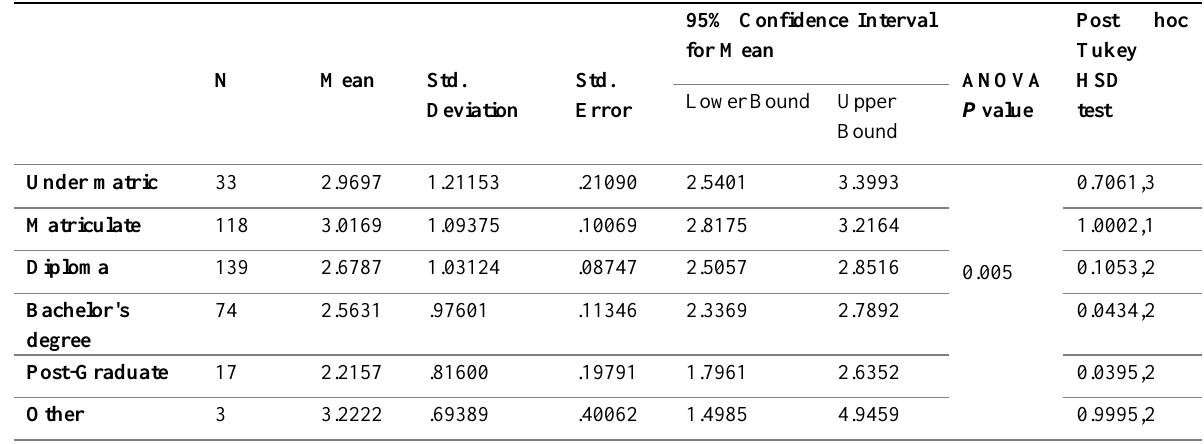
Table 8: Relationship between the level of education and purchase of green